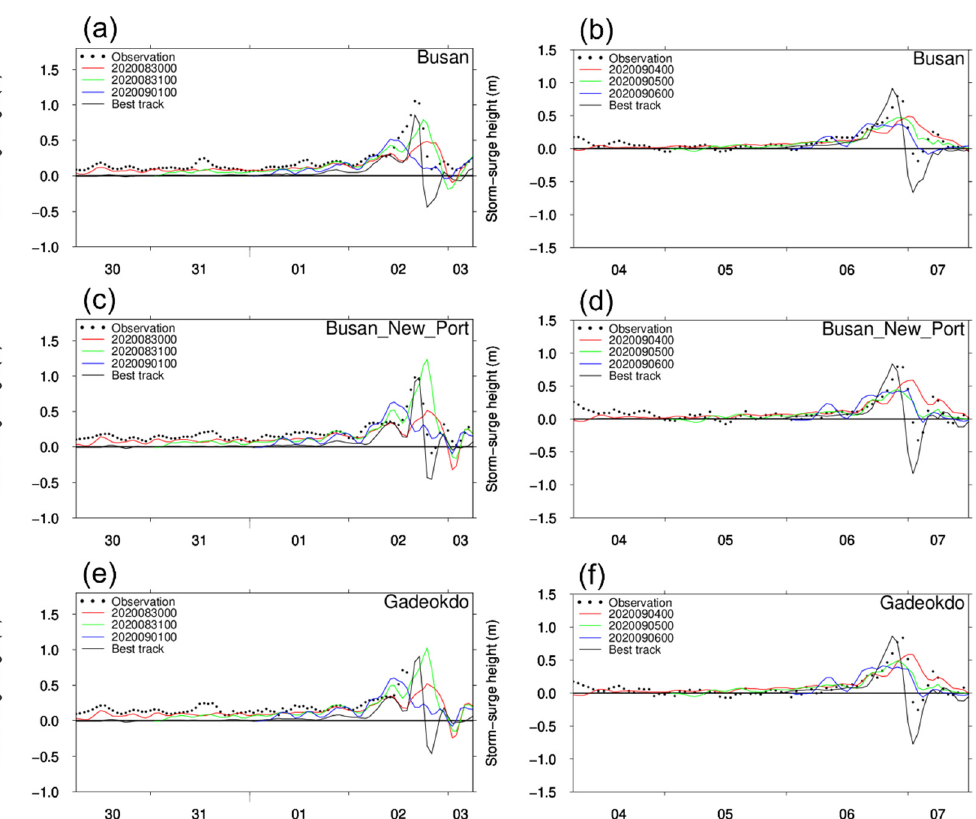
Figure 8. Comparison of the MPAS forecast and the hindcast with the tide observation stations (Busan, Busan_New_Port, and Gadeokdo) of storm surge height for typhoons Maysak ( a , c , e ) and Haishen ( b , d , f ). Here, the x -axis indicates the time with the date of the simulation period, and the interval of observation data is one hour. Table 4. Same as Table 3, except for storm surge heights (cm).